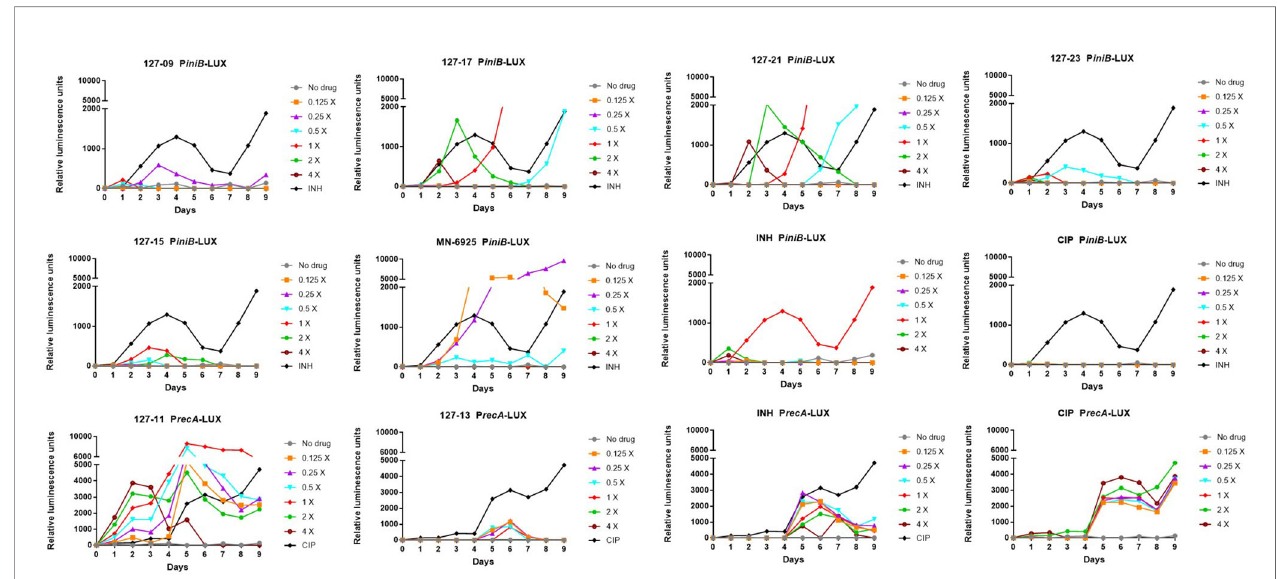
FIGURE 2 | Induction of iniBAC or recA bioluminescent reporter in response to antimycobacterial agents with unknown MoAs at concentrations ranging between 0.125-4× MIC, monitored over 9 days. For P iniB -LUX, INH was used as the positive control at a concentration of 0.39 µM (1× MIC); CIP was used as the negative control. The iniBAC response is shown for 127-09, 127-17, 127-21, 127-23, 127-13, 127-15, MN-6925, and the controls. For P recA -LUX, CIP was used as the positive drug control at 3.13 µM (2× MIC), although concentrations in the range of 0.2 – 6.25 µM (0.125-4× MIC) all gave similar luminescence pro fi les; INH was the negative control. The recA response is shown for 127-11, 127-13 and the controls. RLU, relative luminescence